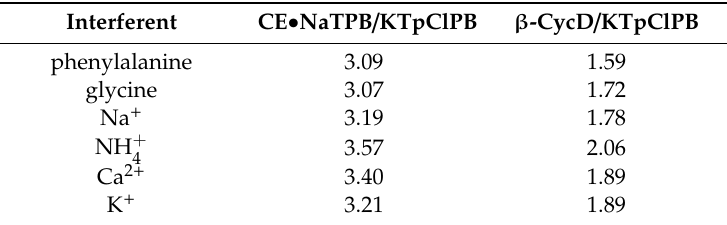
Table 4. Potentiometric selectivity coe ffi cients membrane based sensors (SSM).